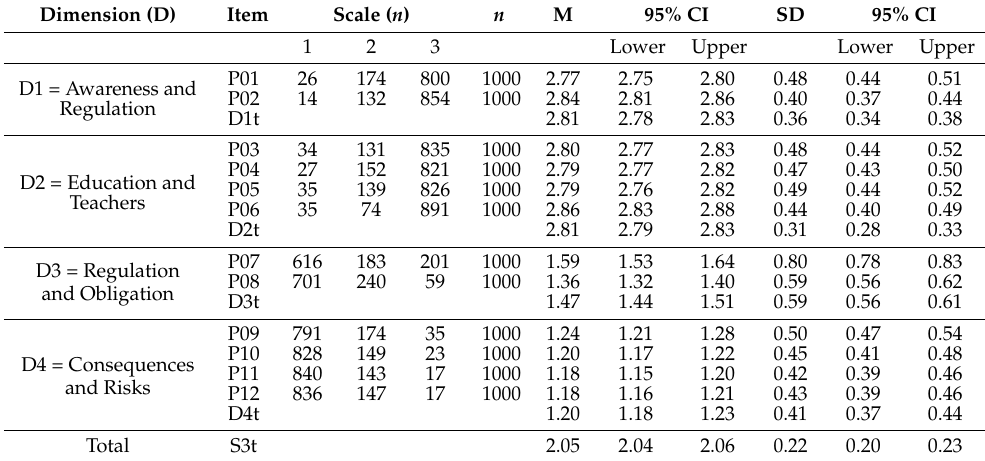
Table 2. Count after the application of the